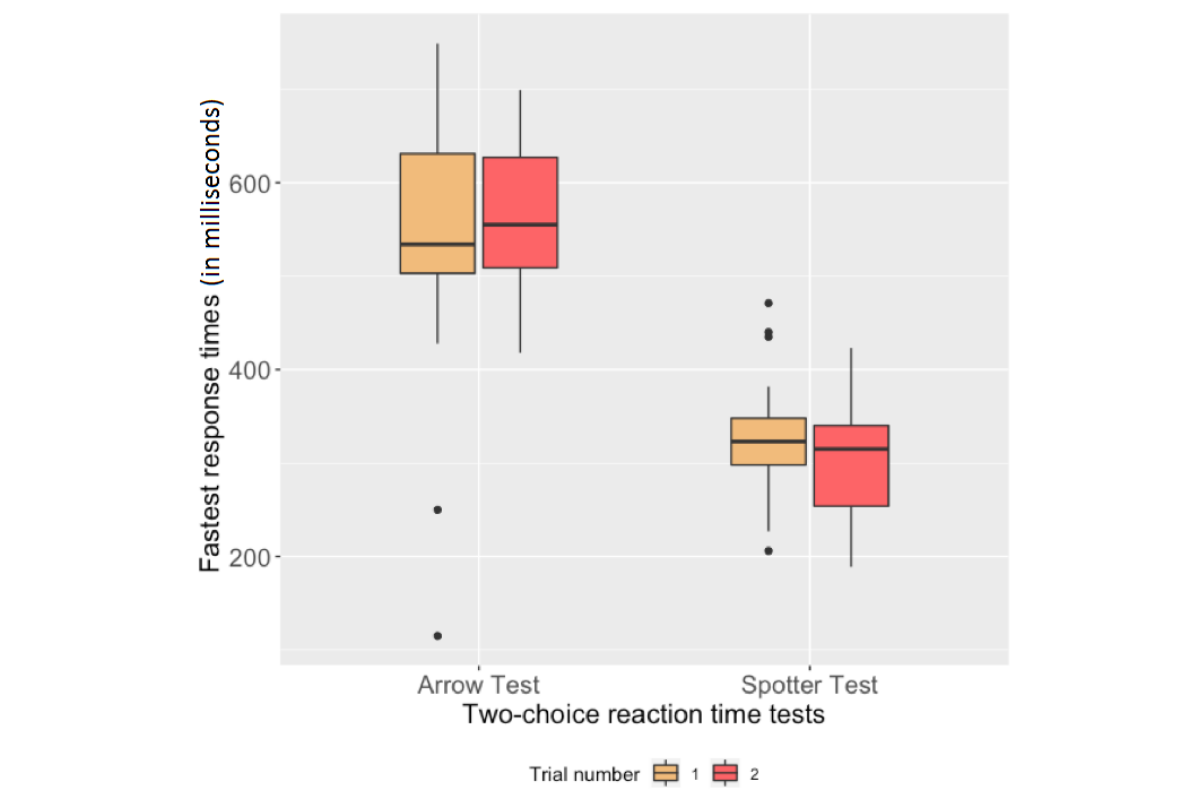
Figure 7. Box plots of participants’fastest response times during the two-choice reaction-time